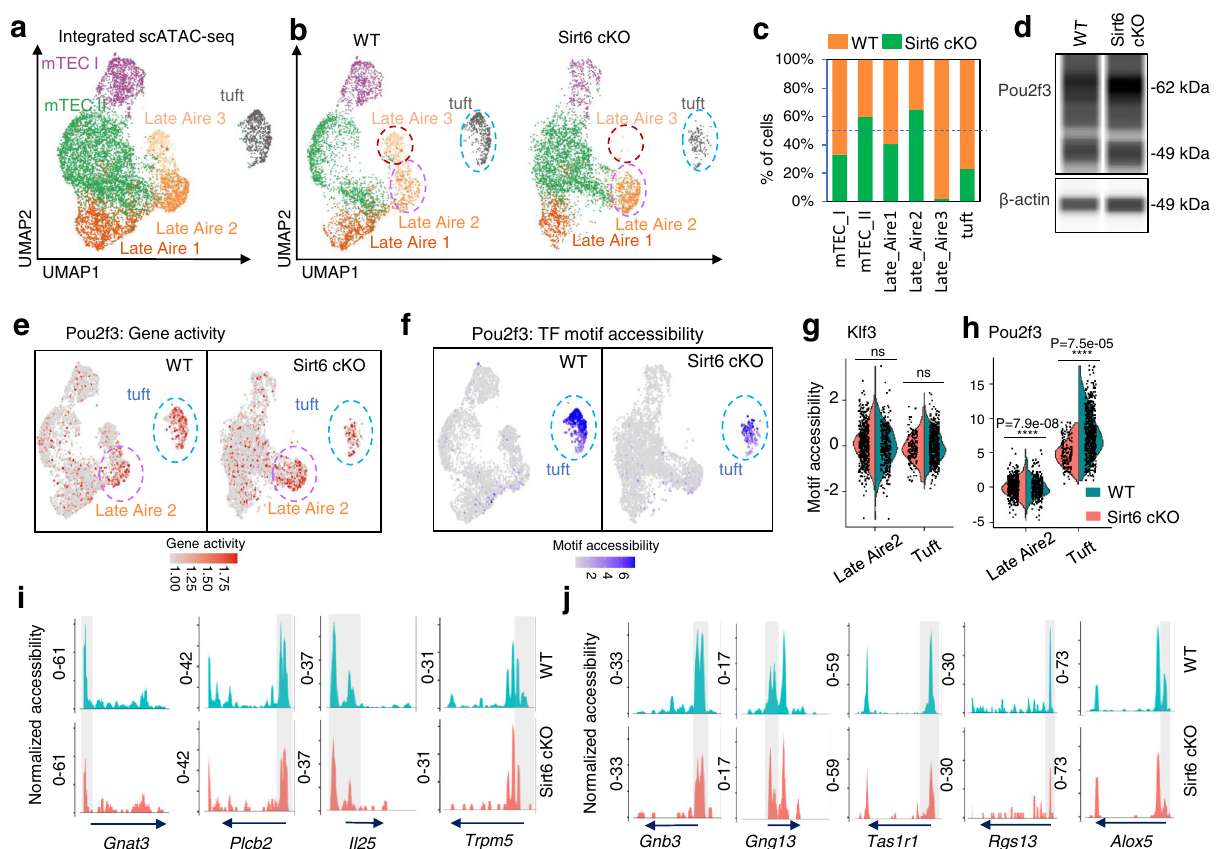
Fig. 5 Chromatin accessibility of the genes regulated by Pou2f3 decreased after Sirt6 deletion. a , b scATAC-seq data of WT and Sirt6 -de fi cient mTECs are coembedded into a single UMAP visualization ( a ) and are displayed separately ( b ). Cells are stained with the mTEC subset de fi ned before. c Relative proportion of mTEC clusters between WT and Sirt6 cKO mice. d Simple Western analysis of POU2F3 expression in sorted mTECs (CD45 − EpCAM + UEA- 1 + Ly51 − ) from 4-week-old WT and Sirt6 cKO mice. e UMAP visualization of the gene expression of Pou2f3 in WT (left) and Sirt6 cKO (right) scATAC-seq. The red scale in the UMAP plot indicates the level of Pou2f3 gene activity in scATAC-seq f UMAP visualization of the motif accessibility score of Pou2f3 in WT (left) and Sirt6 cKO (right) scATAC-seq. The blue scale in the UMAP plot indicates the level of Pou2f3 motif accessibility in scATAC-seq analyzed by chromVAR. g , h Motif accessibility scores of Klf3 ( g ) and Pou2f3 ( h ) in Late Aire 2 cells and thymic tuft cells of WT (Orange) and Sirt6 cKO mice (green) were compared in a violin plot. WT Late Aire 2 cells: n = 272, Sirt6 cKO Late Aire 2 cells: n = 500, WT thymic tuft cells: n = 501, Sirt6 cKO thymic tuft cells: n = 150. i , j Chromatin accessibility peaks of overlapping genes ( i ) and tuft-associated genes ( j ) mentioned in Fig. 3 in WT and Sirt6 -de fi cient thymic tuft cells are shown in aggregated scATAC-seq tracks. The arrow indicates the length and direction of the genes detected by scATAC-seq. The statistics was determined using Wilcoxon signed-rank test. * p < 0.05, ** p < 0.01, *** p < 0.005 and **** p <